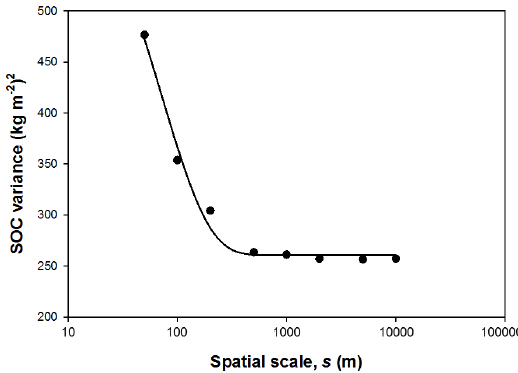
Figure 5. Variance of soil organic carbon stocks as a function Figure 5: of spatial scale. Each dot is predicted variance of SOC stock at each spatial scale across Alaska. The fitted function is SOC vari- ance = 260.61 + 422.42 × exp( − 0.0318 × s) , adjusted R 2 = 0.98, P <0.001.